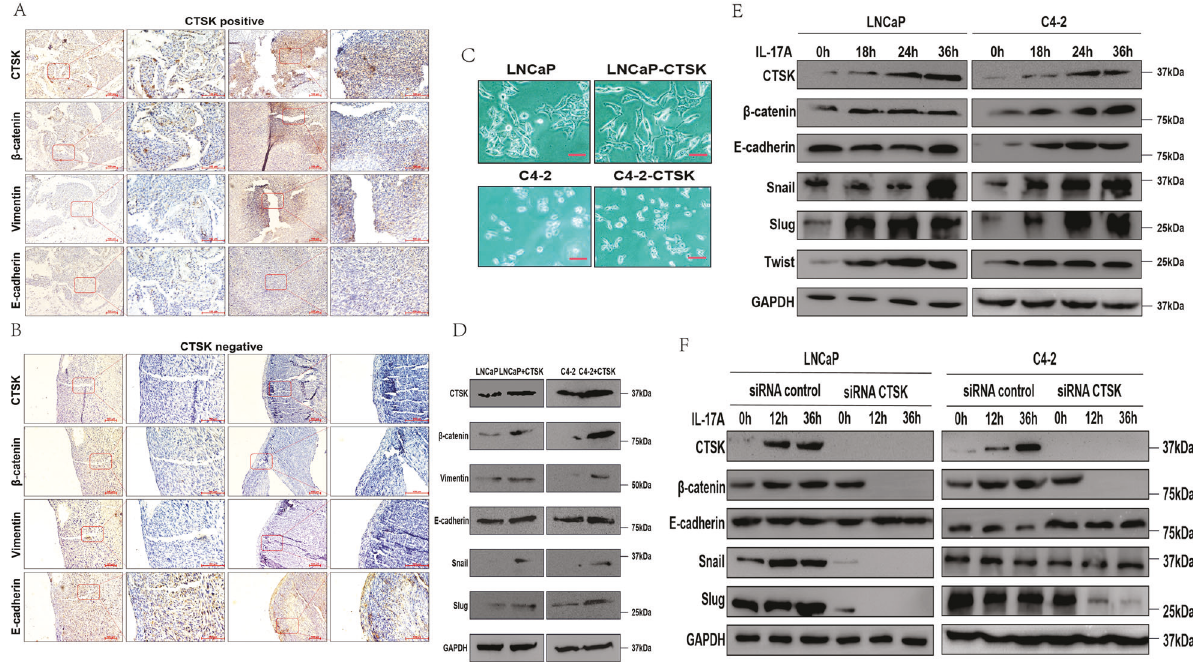
Fig. 4 Enhancement of EMT by IL-17A via CTSK induction. A Subcutaneous tumor tissue of mice is stained for EMT markers ( β -catenin, vimentin, E-cadherin). The mice tumor tissues express excessive CTSK. B Subcutaneous tumor tissue of mice is stained for EMT markers ( β -catenin, vimentin, E-cadherin). The mice tumor tissues express a small amount of CTSK. C Phase-contrast photomicrographs of human prostate cancer cells in monolayer culture. D – F Western blot analysis of EMT markers in human prostate cancer (Fig. 5A) to demonstrate the relationship of immune microenviron- ment with IL-17A/CTSK. The histogram showed that the major immune-in fi ltrating cells associated with PC are T cells (T cells CD4